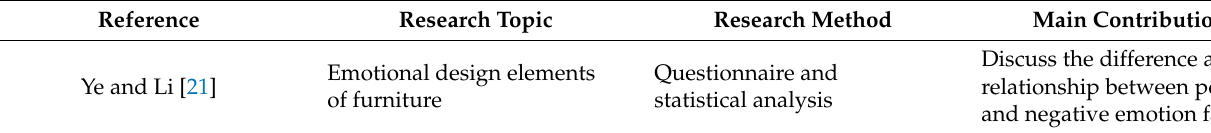
Table 1. Literature review of existing evaluation methods of